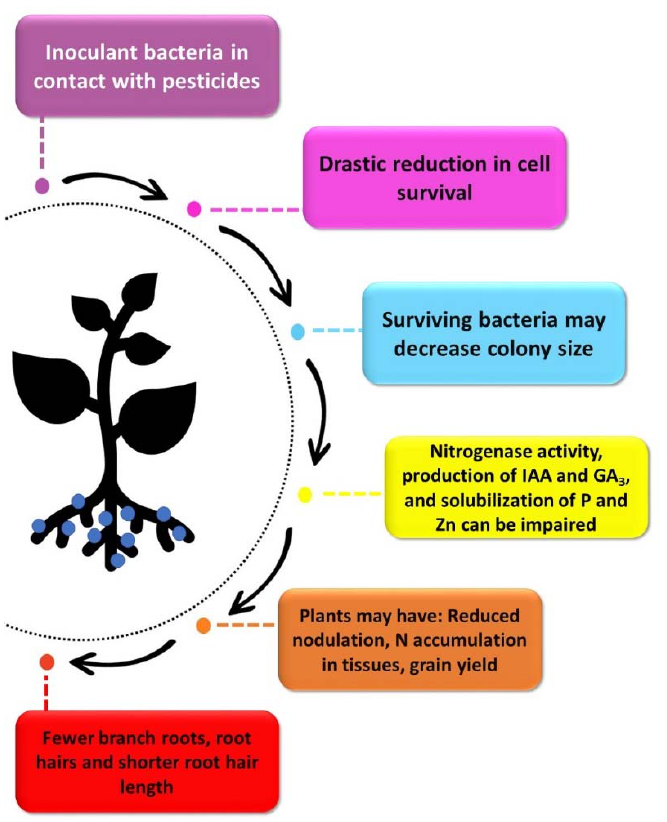
Figure 2. Representation of the effects reported on the incompatibility between pesticides and inoculants, from the moment of contact with microbial cells to the damage to plant development.